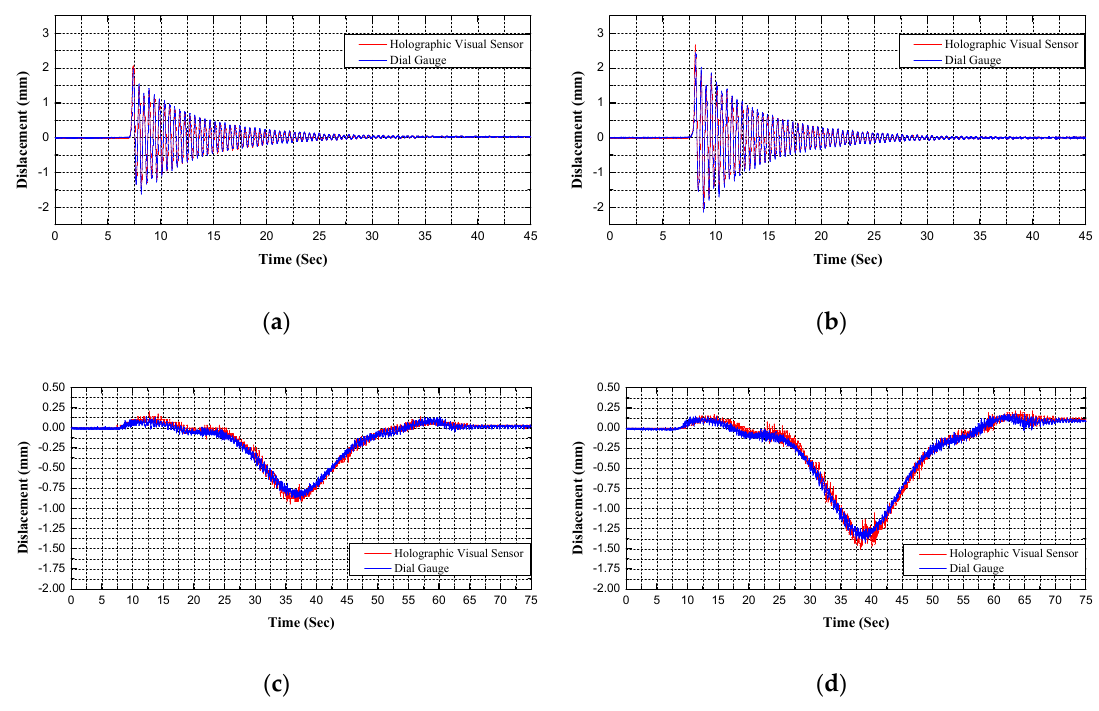
Figure 12. Comparison of displacement responses obtained from test results: ( a ) time history of displacement in B1 condition; ( b ) time history of displacement in B2 condition; ( c ) time history of displacement in C1 condition; ( d ) time history of displacement in C2 condition. Table 2. Test results comparison of holographic visual sensor (HVS) and dial